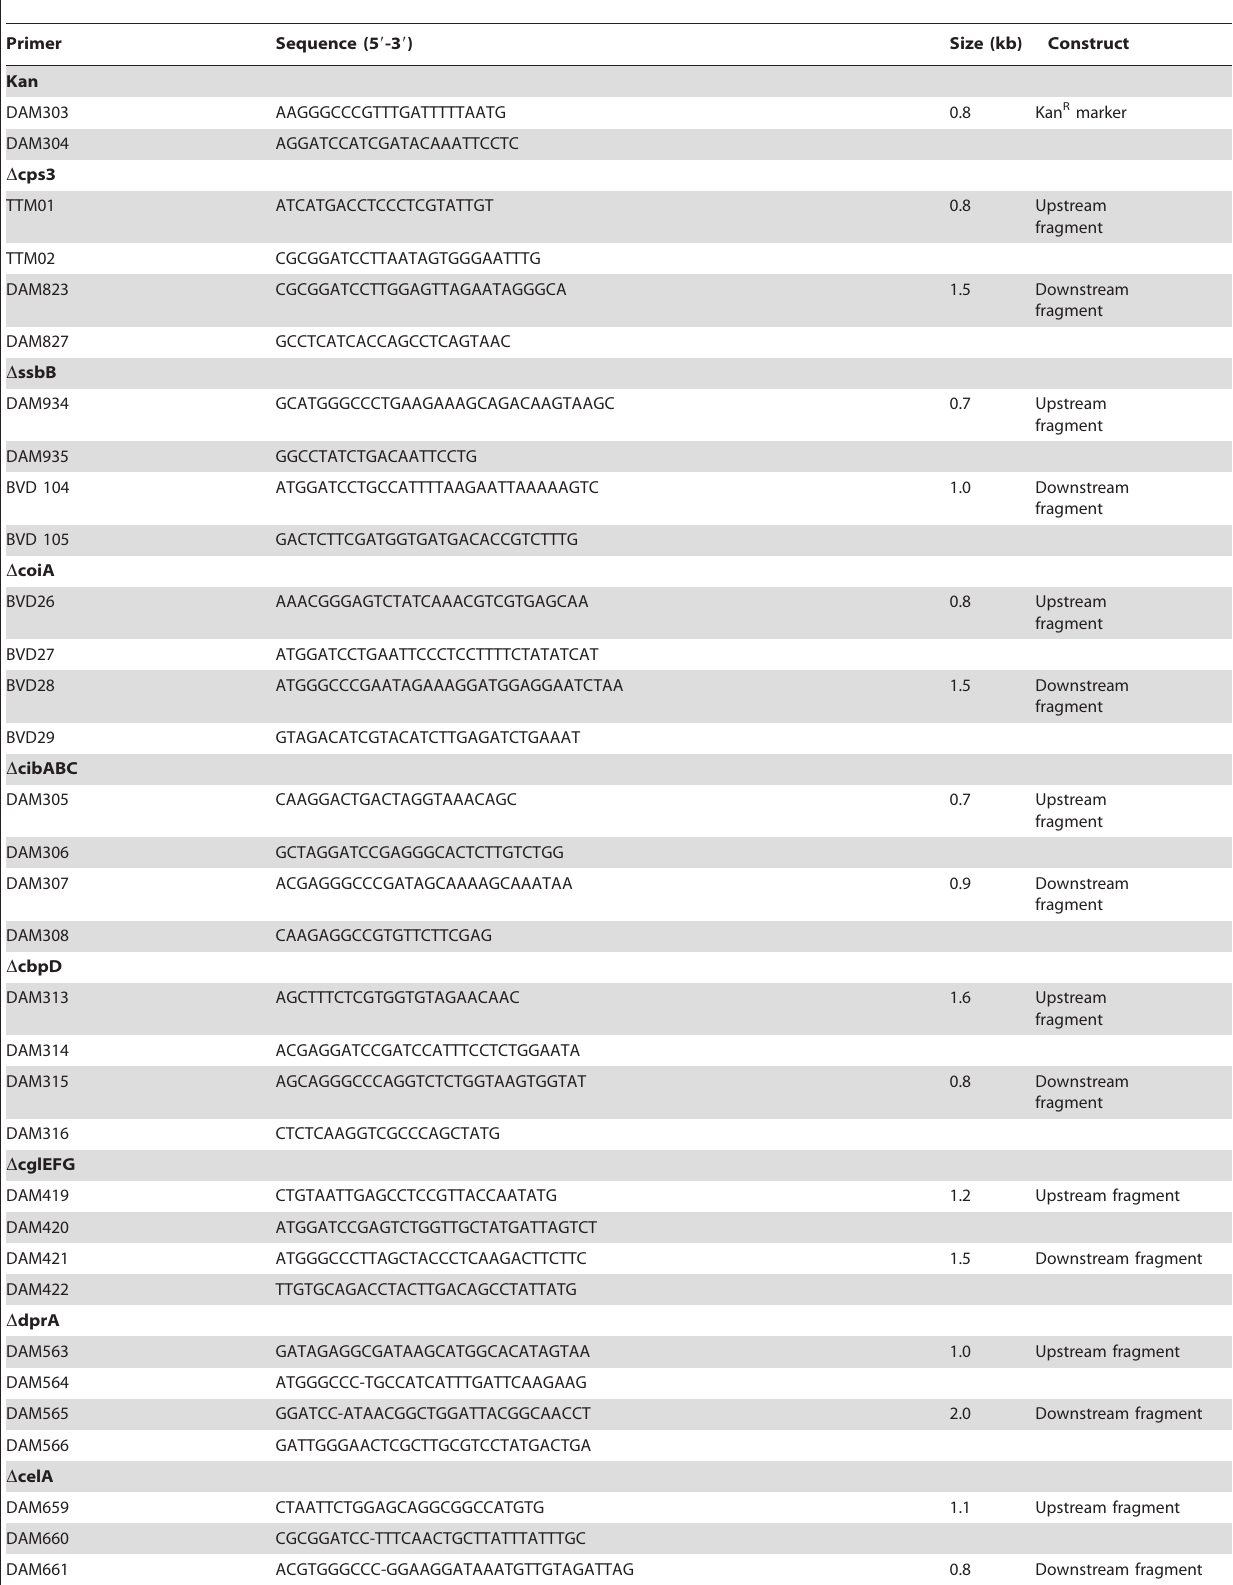
Table 2. Primers used for strain